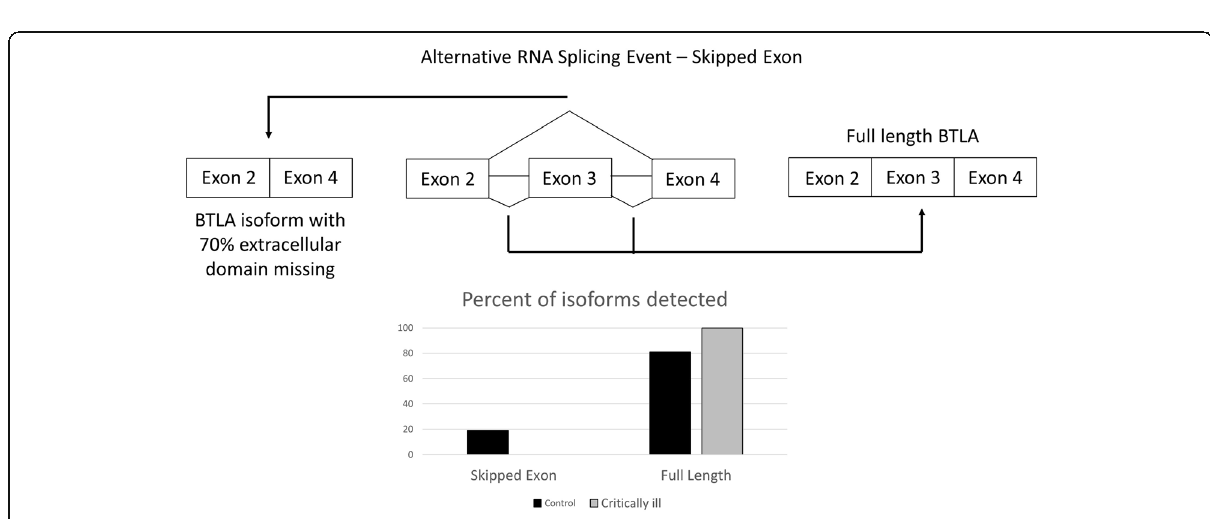
Fig. 2 – Frequency of Skipped Exon in BTLA in critically ill mouse model: The skipping of exon 3 is significantly different between critically ill mice (19%, n = 3) and healthy sham controls (0%, n = 3) (FDR =0.0000471413836931, bar graph to the left). The full length isoform is seen 81% of the time in the control mice and 100% of the time in the critically ill mice (bar graph to the right)